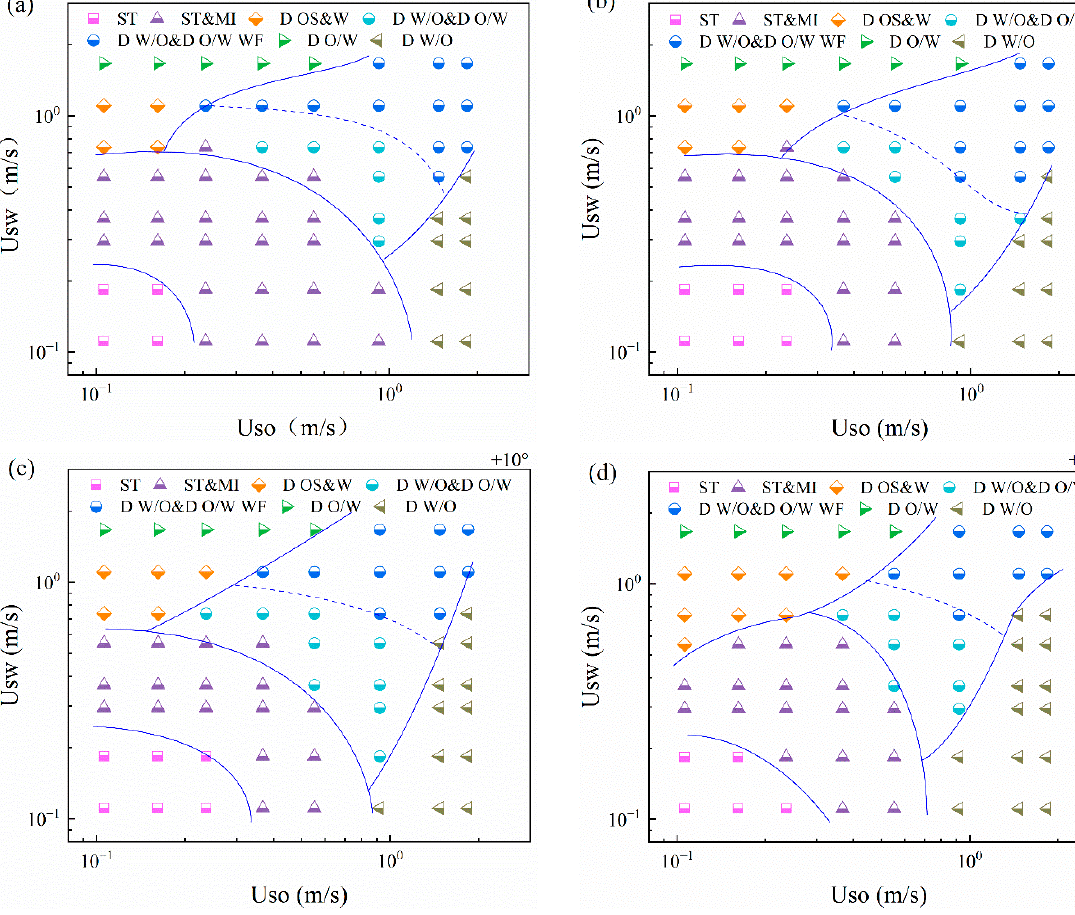
Figure 7. Flow pattern map of horizontal and inclined oil–water two ‐ phase flows: ( a ) 0°; ( b ) + 5°; ( c ) +10°; ( d ) +15°.